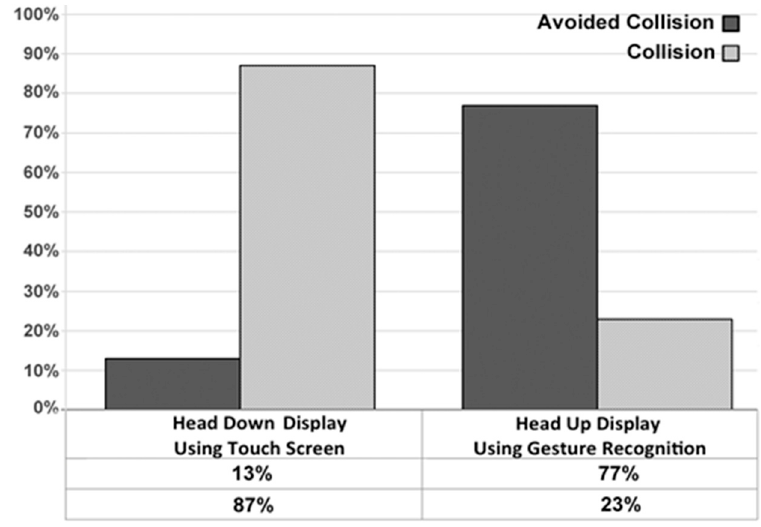
Figure 12. Number of collisions recorded with HDD vs. HUD interface.